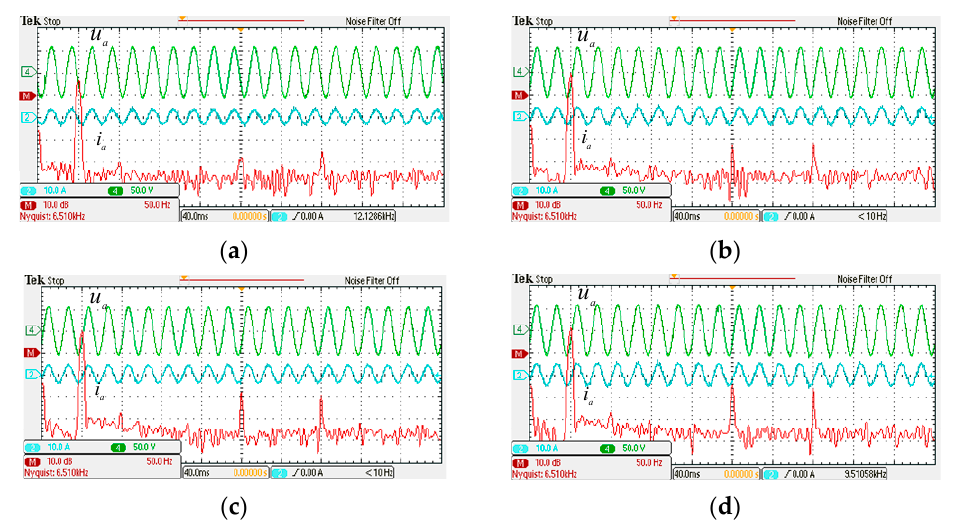
Figure 12. The experimental waveforms of the grid currents and the corresponding FFT analysis for different overlap times at 10 kHz switching frequency. ( a ) t ov = 0 μ s. ( b ) t ov = 3 μ s. ( c ) t ov = 5 μ s. ( d ) t ov = 7 μ s.